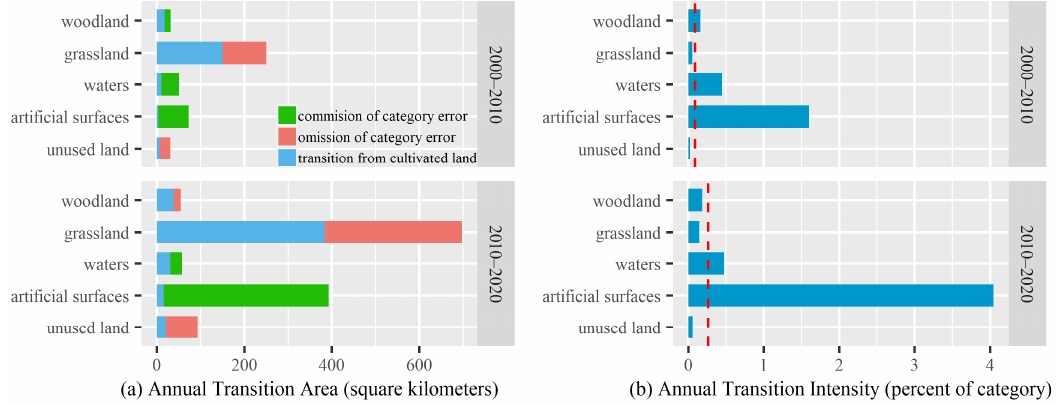
Figure 16. Intensity analysis for cultivated land loss in the upper reaches. The transition size along with hypothetical map errors ( a ); transition intensities ( b ). The red, vertical dashed lines indicate the uniform intensities.